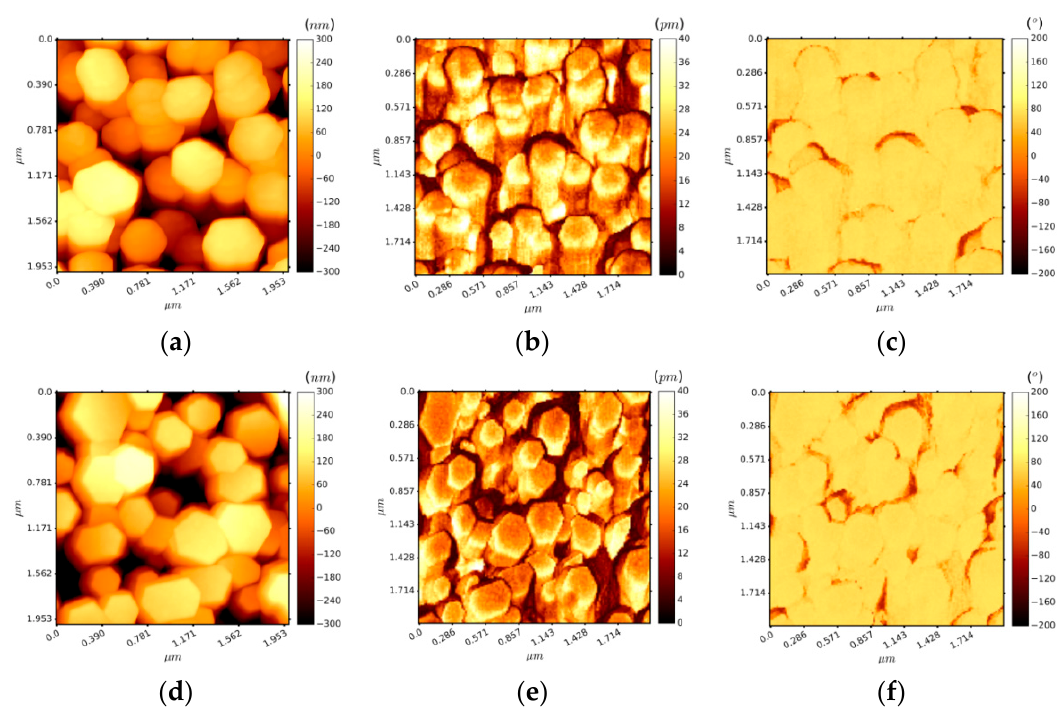
Figure 5. PFM images of the ( a , b ) topography, ( c , d ) amplitude, and ( e , f ) phase of the ZnO NW growth on ZnO (ALD)/ITO/Si (images lined up above) and as-printed (not sintered) ZnO seed layer/ITO/PET substrates (images lined up below).